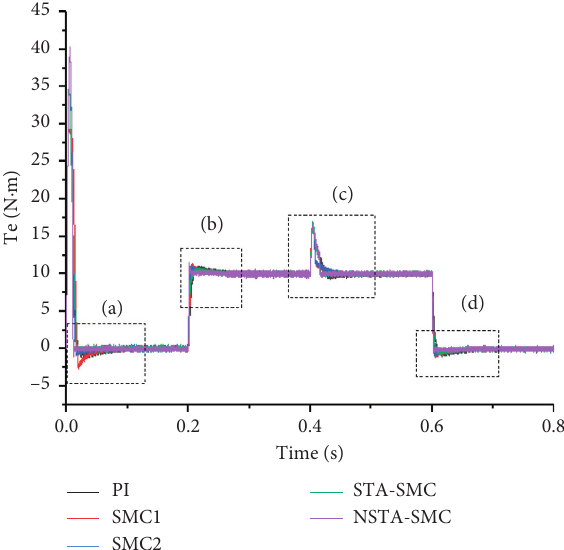
Figure 8: Torque response diagram.